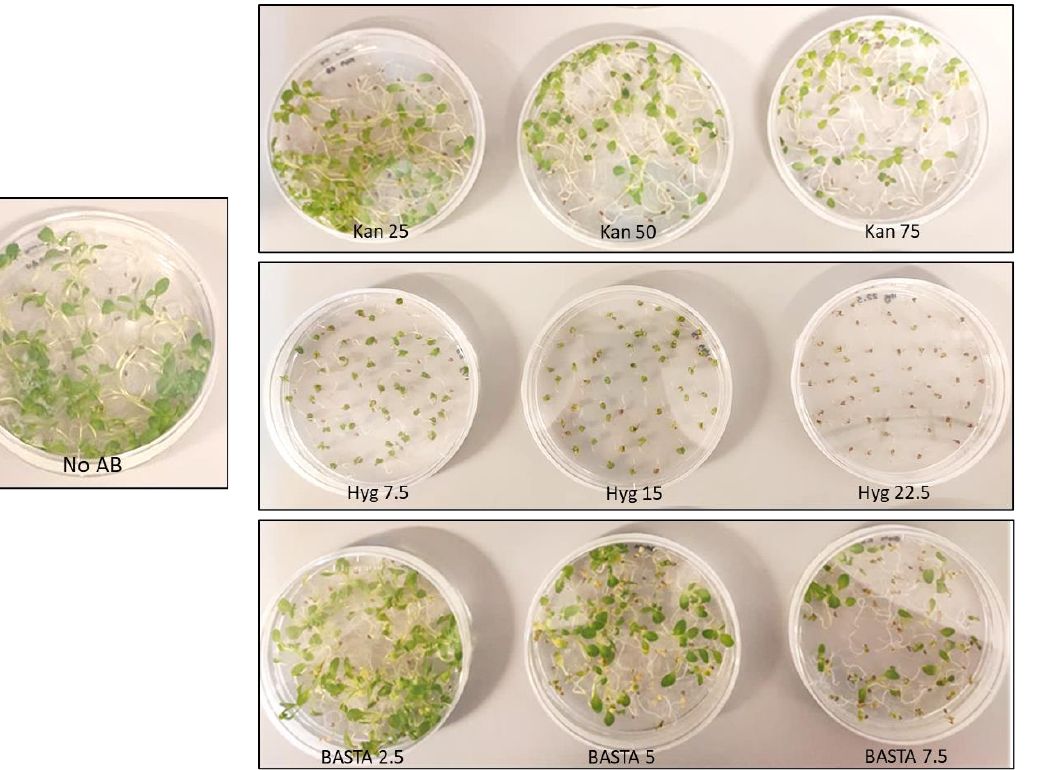
Figure 1. Dosage experiment for kanamycin (Kan), hygromycin (Hyg) and BASTA in WT Camelina seeds after 20 days of growth. Doses in mg/L. No AB: MS media without added antibiotics as a control.